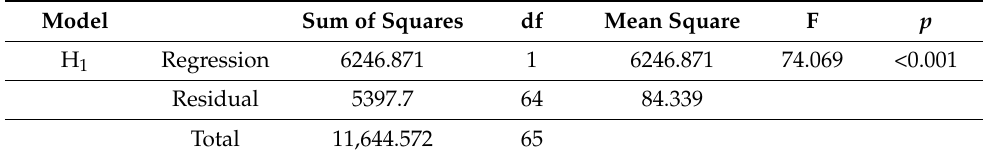
Table 6. Vertical dry plate method and wet candle method—ANOVA.